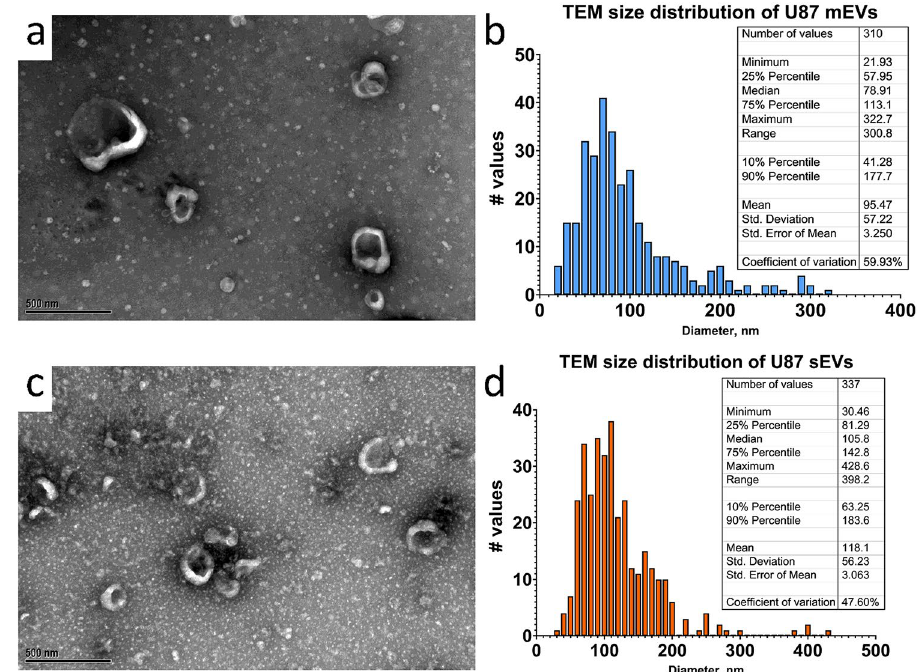
Figure 4. Characterization of U87 EV size by TEM. (a) Representative TEM of mEVs and (b) corresponding size distribution, (c) representative TEM of sEVs and (d) corresponding size distribution including descriptive statistics tables. The images of EV samples isolated in the laboratory of J.L. Hood were obtained through contract services with Alpha Nano Tech LLC (Morrisville, NC,